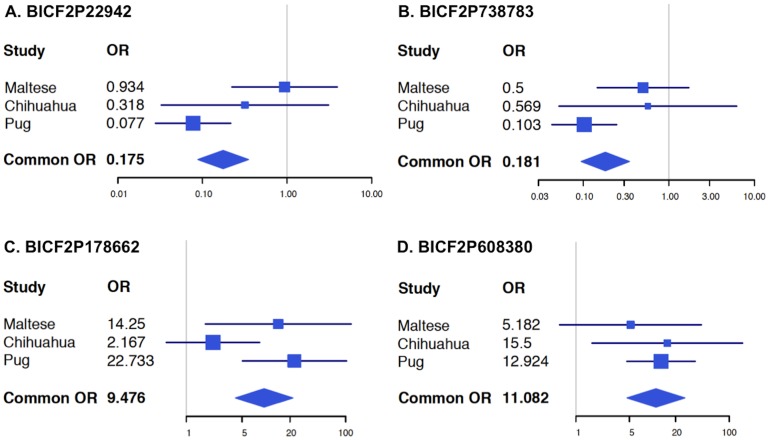
Forest plots of four SNPs in the dog leukocyte antigen II region on chromosome 12 across three toy breeds with necrotizing meningoencephalitis.(a) BICF2P22942: p = 1.57×10−7, OR = 0.18 (0.09–0.35), (b) BICF2P738783: p = 4.11×10−8, OR = 0.18 (0.10–0.34), (c) BICF2P178662: p = 1.11×10−9, OR = 9.48 (4.19–21.40), and (d) BICF2P608380: p = 8.6×10−11, OR = 11.08 (4.72–26.01). The 95% confidence interval for each study is represented by a horizontal line, and the point estimate is given by a square, the height of which is inversely proportional to the standard error of the estimate after each study. The summary OR is indicated by a diamond with horizontal limits as the confidence limits and height inversely proportional to its standard error. The meta-analyses for all these SNPs were significant and effect sizes were in the same direction.